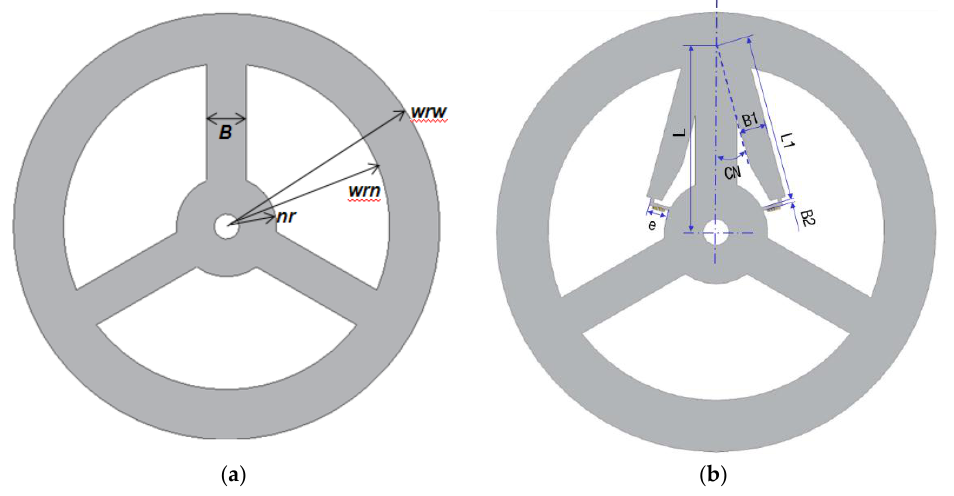
Figure 9. Design variables of torque sensors. ( a ) 3-beam torque sensor; ( b ) TSHS. Table 1. Parameters of the TSHS.